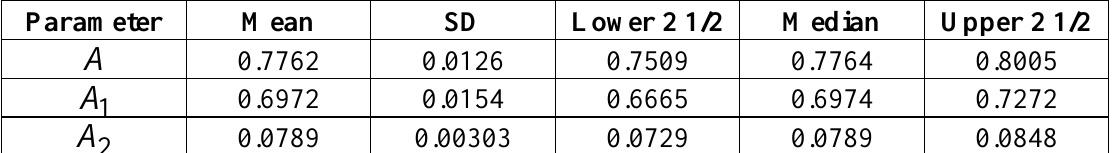
Table 17. Posterior analysis for mammography